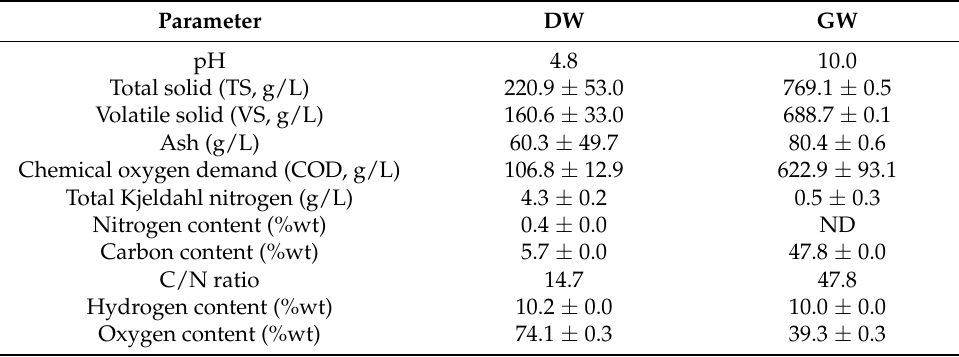
Table 1. Distillery wastewater (DW) and glycerol waste (GW)